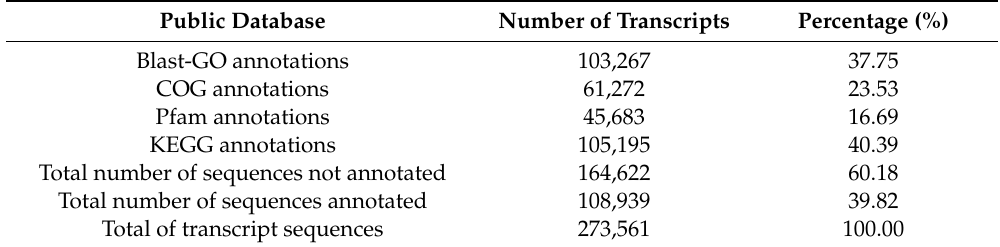
Table 2. Summary of the functional annotation of transcript sequences from A. sinapina obtained from public